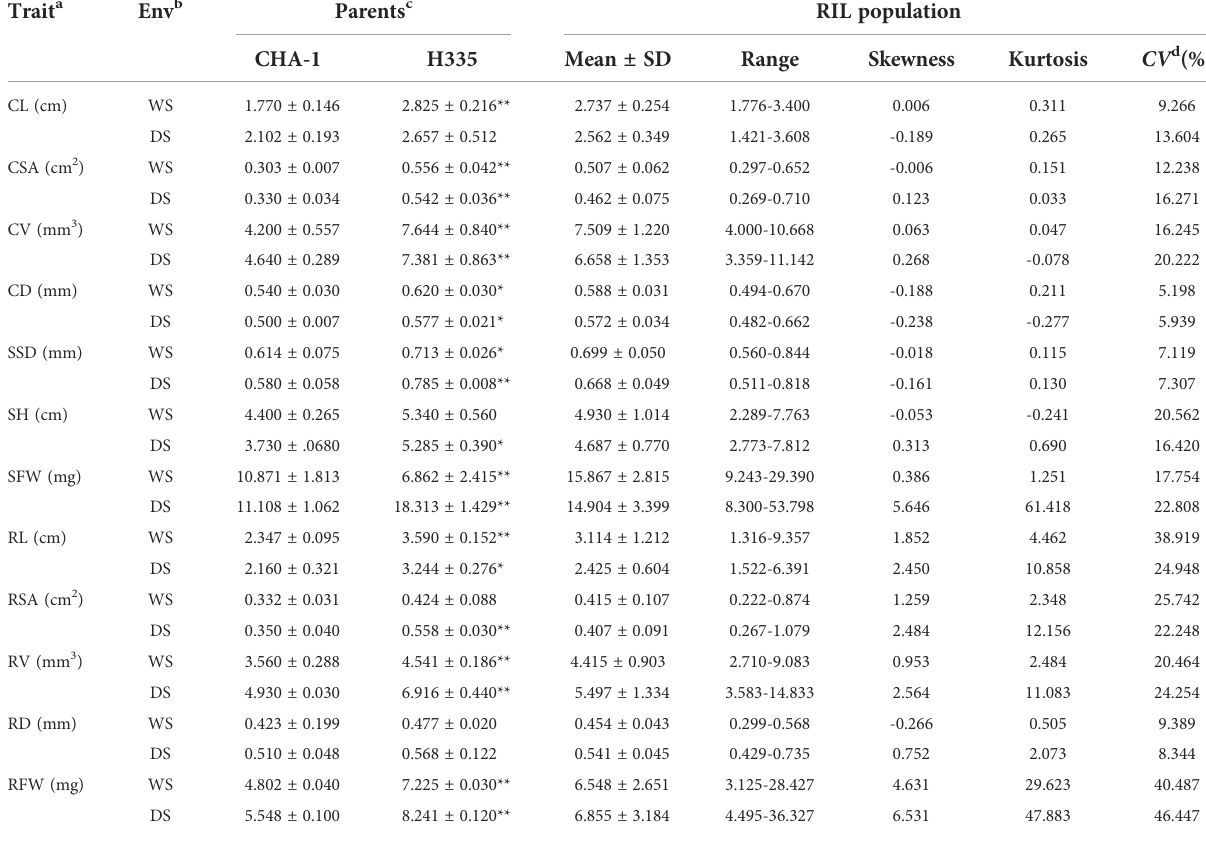
TABLE 2 Phenotypic performance during the germination and the bud stage under anaerobic stress across two cropping